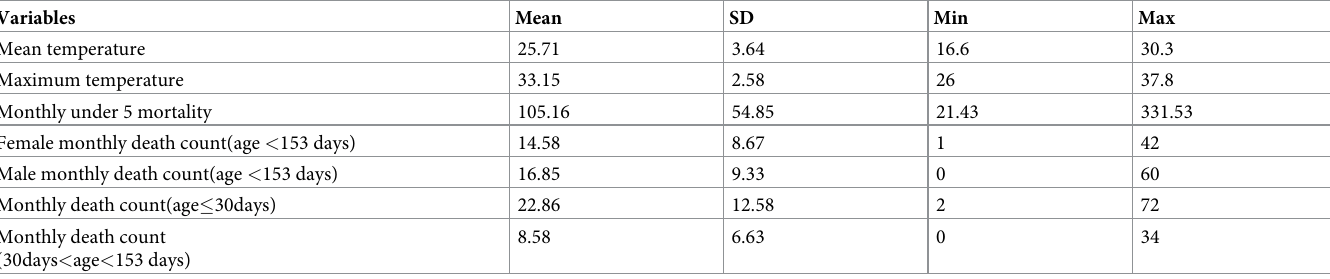
Table 1. Summary statistics of variables used in the analysis.